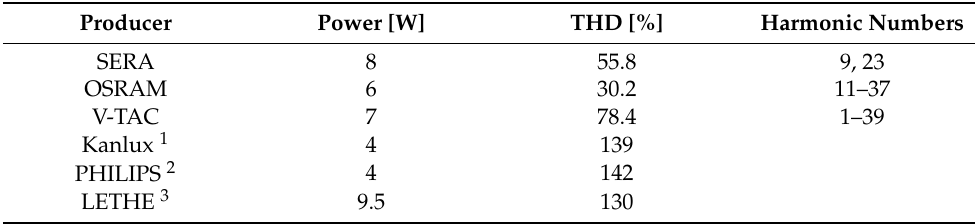
Table 2. THD and harmonic numbers that were exceeded.